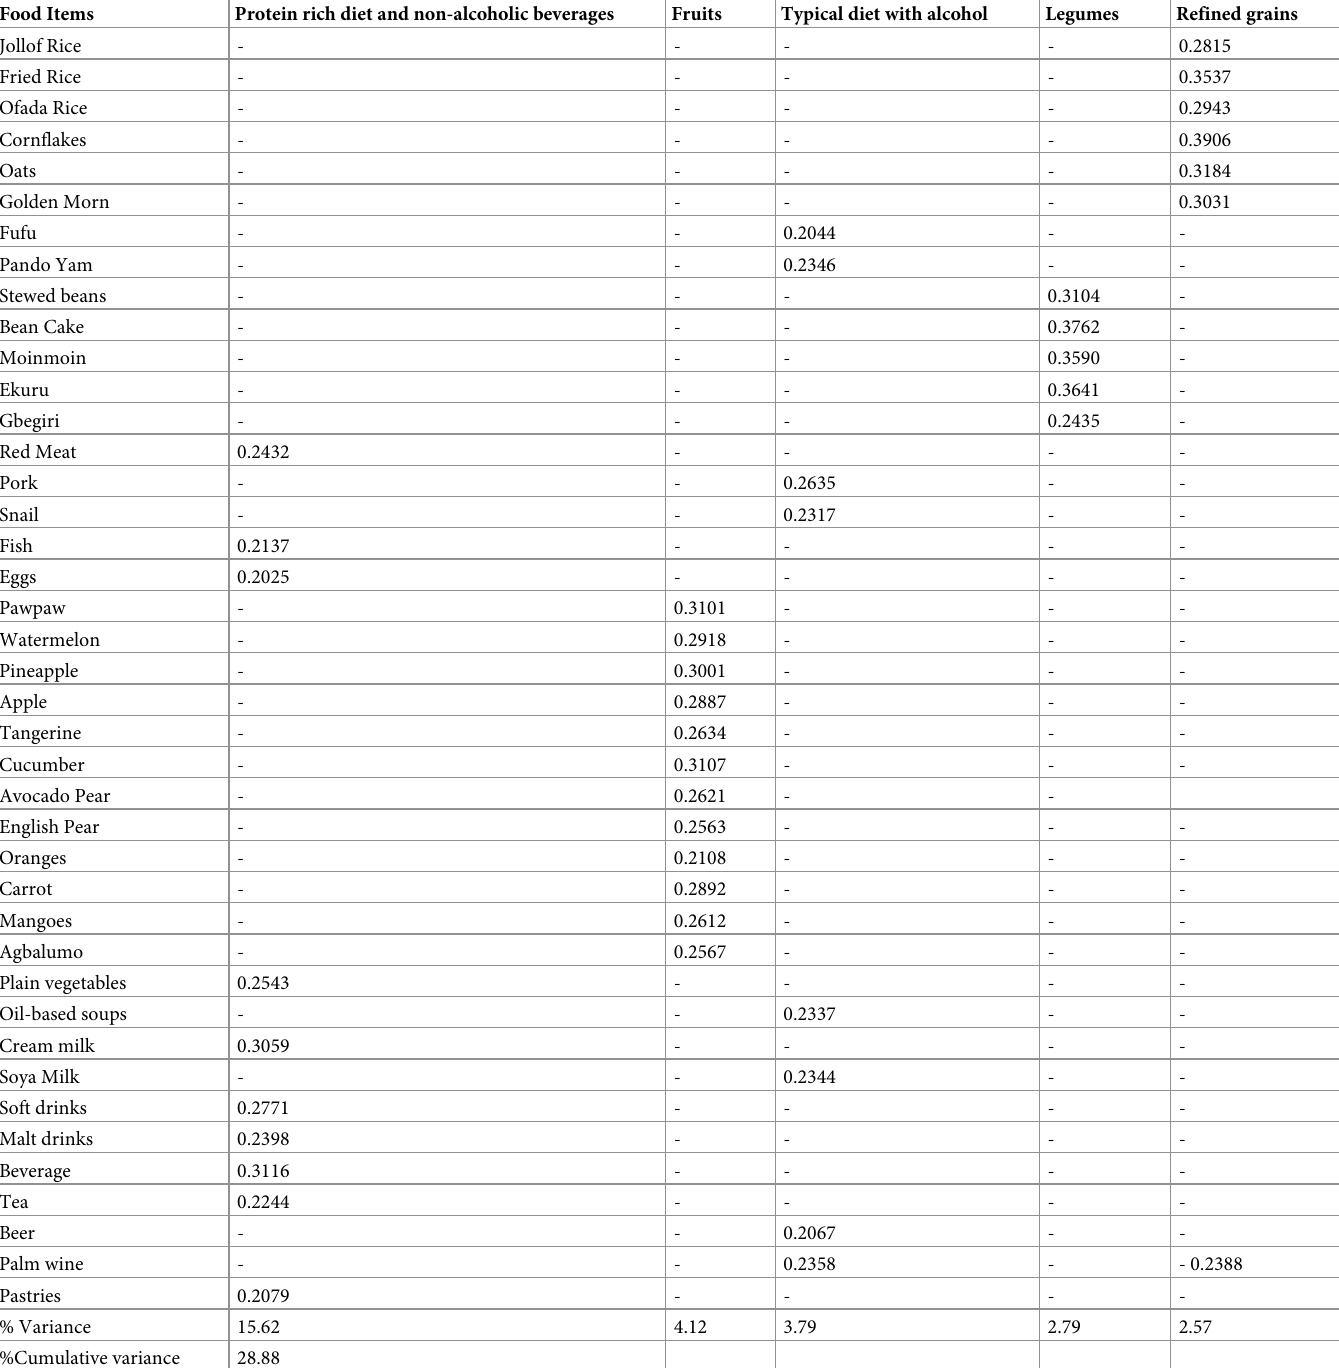
Table 3. Factor loading matrix of 5 dietary patterns obtained by principal component analysis. Food